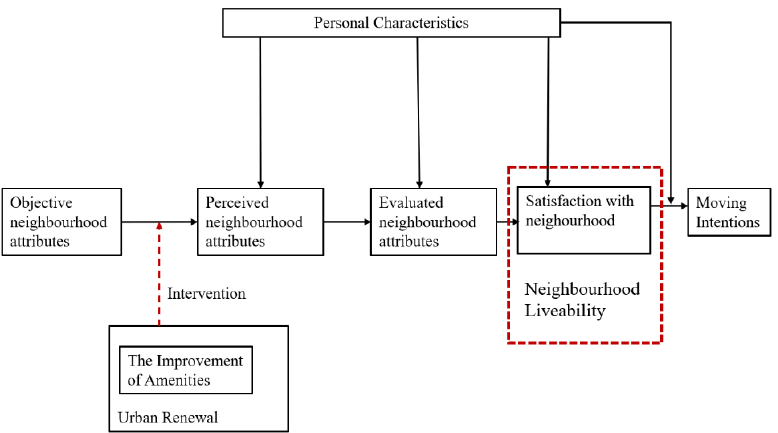
Figure 3. The framework for affecting neighbourhood satisfaction by improving neighbourhood amenities (adapted from Campbell et al. (1976) [2]; Marans and Rodgers (1975) [38], and Low et al. (2018) [39]).